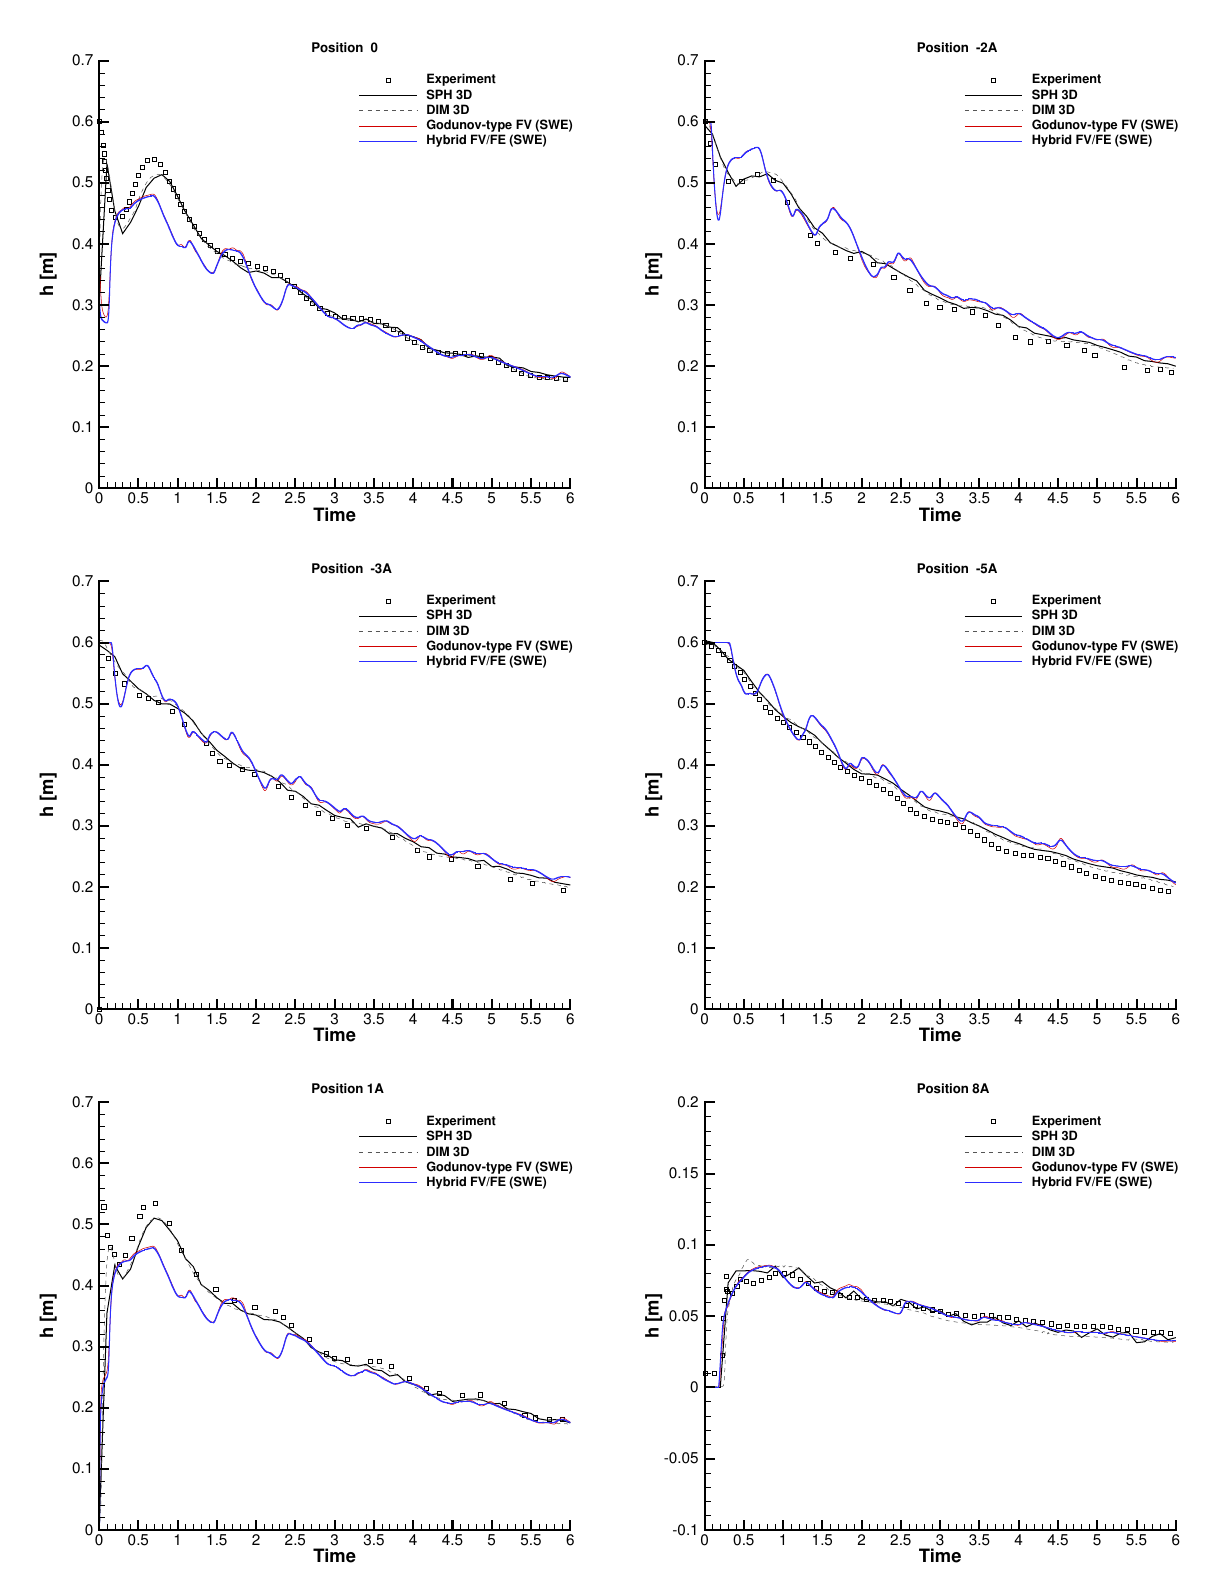
2 A, 3 A, 5 A, 1 A and 8 A for the − − −